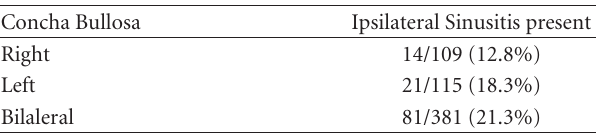
Table 4: Relationship of right, left, or bilateral concha bullosa, compared to the presence of ipsilateral sinusitis.